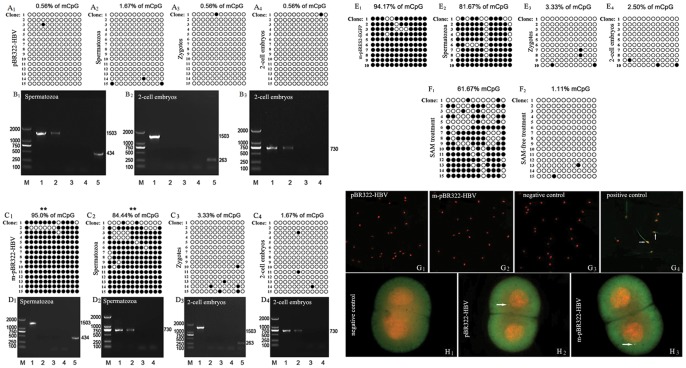
LTR methylation and gag expression of HIV-1 in the plasmid-transfected spermatozoa and sperm-derived zygotes and 2-cell embryos.A: The detection of LTR methylation by BSP and Thymine/Adenine cloning while transfection with unmethylated plasmid. The methylation status of 15 clones for each sample is presented; each column represents one CpG position in the U3-R region, with each circle in the column indicating either cytosine (open circles) or methyl cytosine (filled circles), the same below. (A1) plasmid; (A2) spermatozoa; (A3) zygotes; (A4) 2-cell embryos. B: The detection of gag transcription while transfection with unmethylated plasmid (B1) the results of RT-PCR. M: Marker; 1: positive control; 2: spermatozoa; 3: -RT; 4: -T; 5: human β-actin. (B2) the results of first-round of nested RT-PCR. M: Marker; 1: positive control; 2∶2-cell embryos; 3: -RT; 4: -T; 5: hamster β-actin. (B3) the results of second-round of nested RT-PCR. M: Marker; 1: positive control; 2: the first round product; 3: -RT; 4: -T. The results showed a clear correlation between LTR methylation and gag transcription of HIV-1 either in spermatozoa or in 2-cell embryos. C: The detection of LTR methylation while transfection with methylated plasmid. (C1) plasmid; (C2) spermatozoa; (C3) zygotes; (C4) 2-cell embryos. D: The detection of gag transcription while transfection with methylated plasmid. (D1) the results of first-round of nested RT-PCR. M: Marker; 1: positive control; 2: spermatozoa; 3: -RT; 4: -T; 5: human β-actin. (D2) The results of second-round. M: Marker; 1: positive control; 2: the first round product; 3: -RT; 4: -T. (D3) the results of first-round of nested RT-PCR M: Marker; 1: positive control; 2∶2-cell embryos; 3: -RT; 4: -T; 5: hamster β-actin. (D4) the results of second-round. M: Marker; 1: positive control; 2: the first-round product; 3: -RT; 4: -T. The results showed a clear correlation between LTR methylation and gag transcription of HIV-1 either in spermatozoa or in 2-cell embryos. E: CMV methylation in the spermatozoa transfected with methylated pIRES2-EGFP and sperm-derived zygotes and 2-cell embryos. The detection of CpG methylation by BSP and Thymine/Adenine cloning. (E1) m-pIRES2-EGFP; (E2) spermatozoa; (E3) zygotes; (E4) 2-cell embryos. The results showed that demethylation of some CpG sites in CMV promoter has already occurred in the spermatozoa and almost all CpG sites were demethylated in zygotes and 2-cell embryos. F: The effects of SAM on methylation of CpG sites in HIV-1 LTR in the 2-cell embryos. (F1) SAM treatment; (F2) SAM-free treatment. The results showed that the methylation rate of HIV-1 LTR in 2-cell embryos markedly increased after treatment with SAM. G: The detection of HIV-1 Gag translation in spermatozoa by IF assay. (G1) transfection with unmethylated plasmid; (G2) transfection with methylated plasmid; (G3) negative control; (G4) positive control. No positive signal for HIV-1 P24 Gag protein was observed in (G1), (G2) and (G3), and the strong signals for sperm protein were visible in (G4). H: The detection of Gag translation in 2-cell embryos by IF assay. (H1) negative control; (H2) derived from unmethylated sperm; (H3) derived from methylated sperm. The positive signal for HIV-1 P24 Gag protein was observed in (H2) and (H3). The results showed that HIV-1 gag was able to express its protein in the 2-cell embryos and not in the spermatozoa.